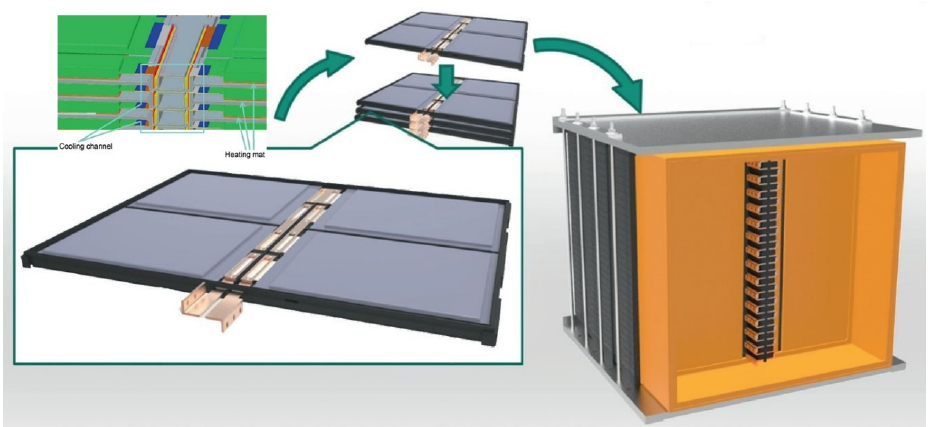
Figure 1. Scalable battery solution developed by Karlsruhe Institute of Technology for automotive application [27].